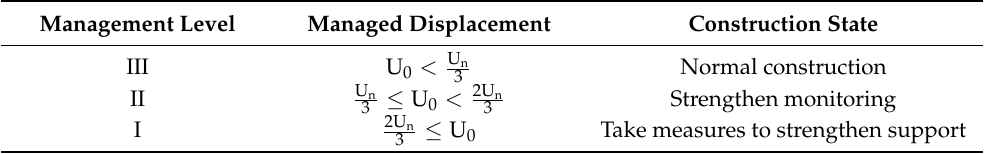
Table 3. Monitoring data